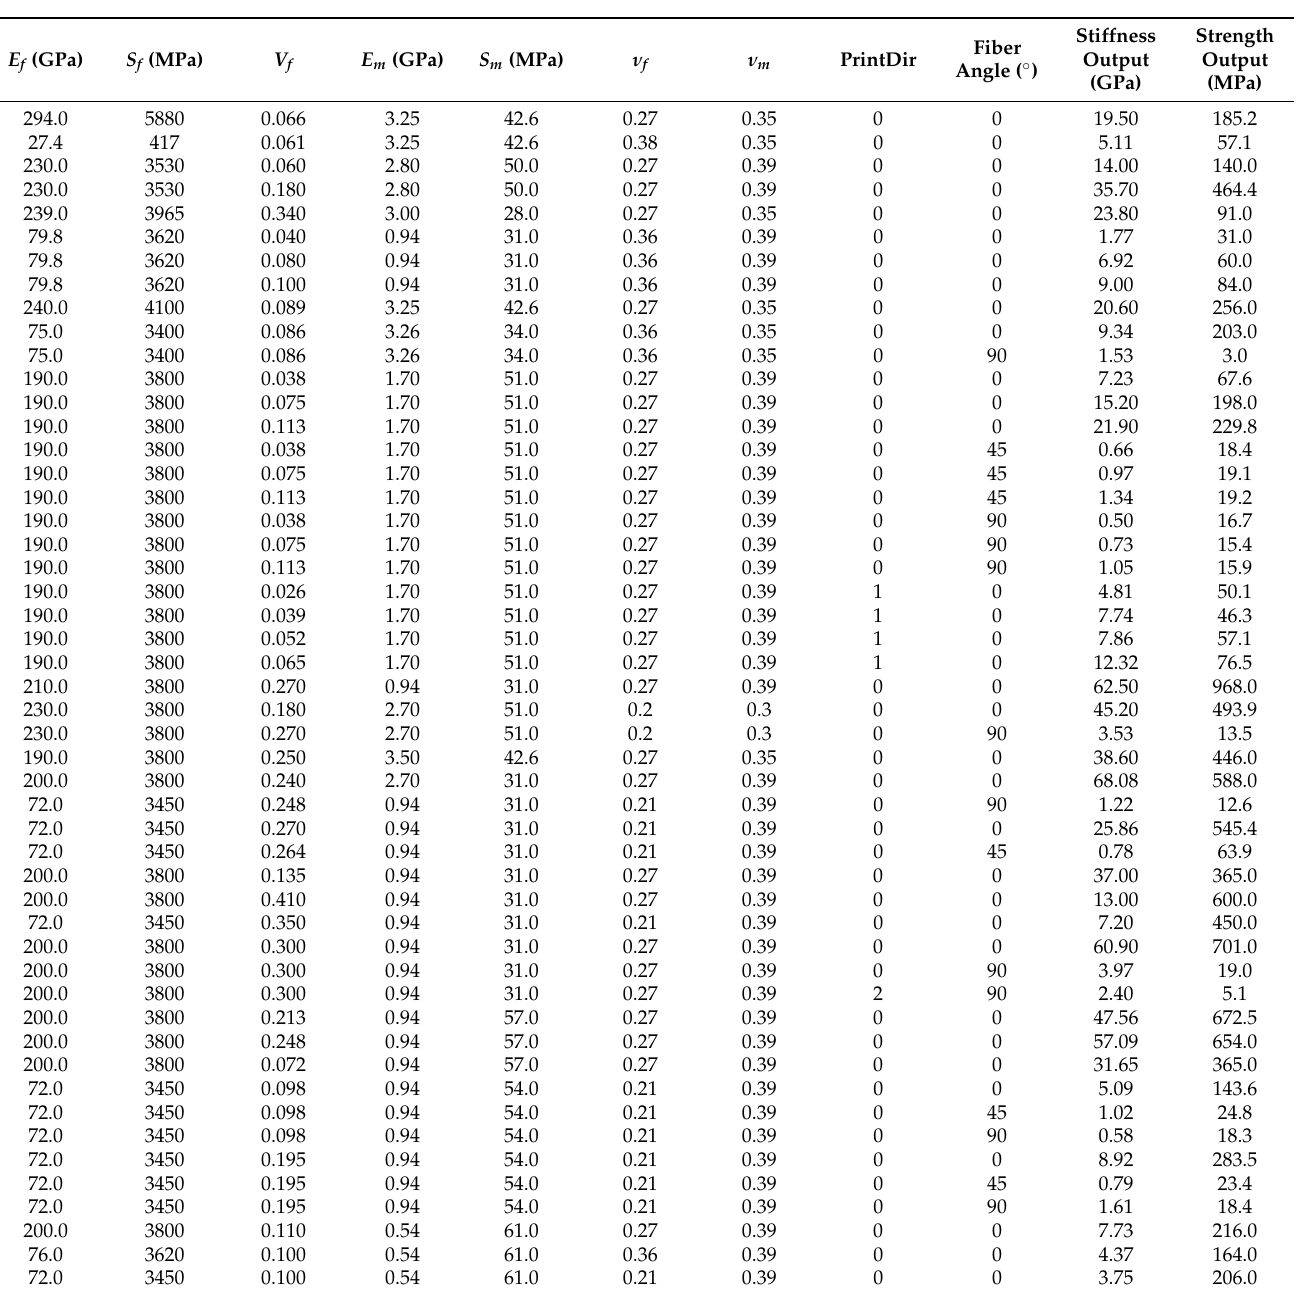
Table A1. Experimental data obtained following ASTM